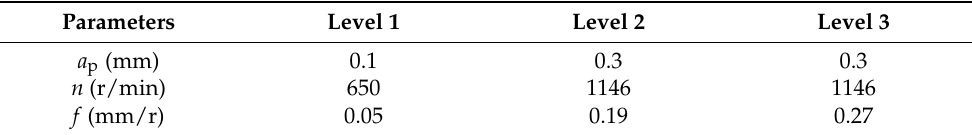
Figure 2. Configuration of fatigue specimen. ( a ) geometry design plan; ( b ) photo of specimens.